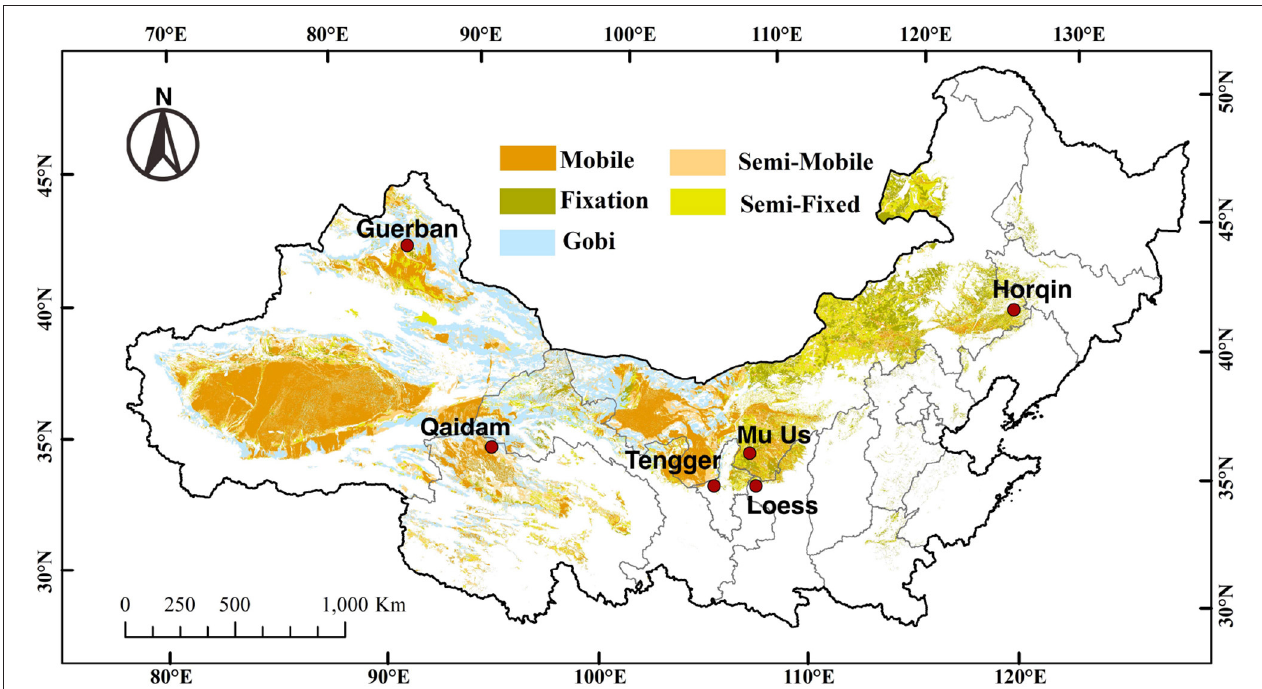
FIGURE 1 | The distribution of 6 study sites dispersed across different desert regions of northern China, i.e., the Horqin Desert (Horqin), western Loess Plateau (Loess), Mu Us Desert (Mu Us), Tengger-Alxa Desert (Tengger), Guerbantunggut Desert (Guerban), and Qaidam Desert (Qaidam) (Yan and Wang, 2019). The different colors mark the different classifications of